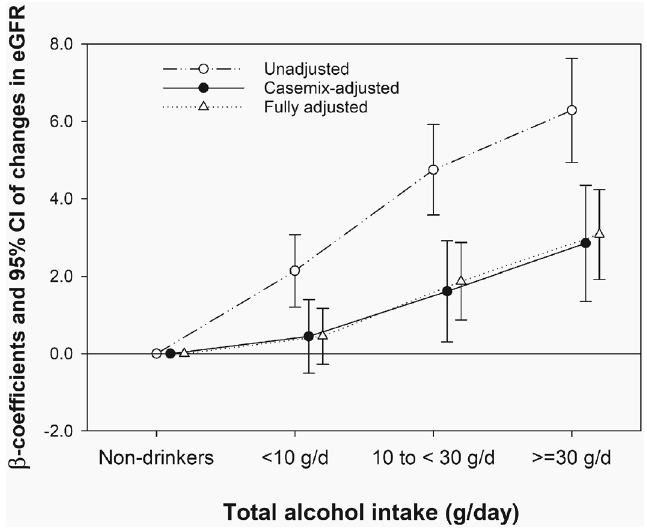
Figure 1. The association of baseline alcohol consumption and decline in kidney function over 12 years among 5729 participants. Points and bars represent beta coefficients and 95% confidence intervals, respectively.